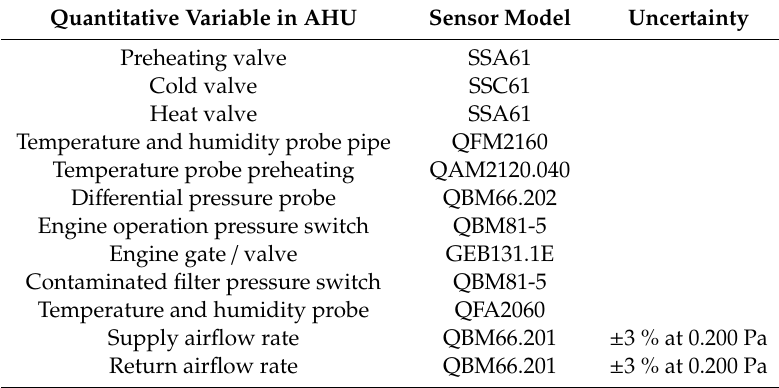
Table 3. Equipment in AHUs.